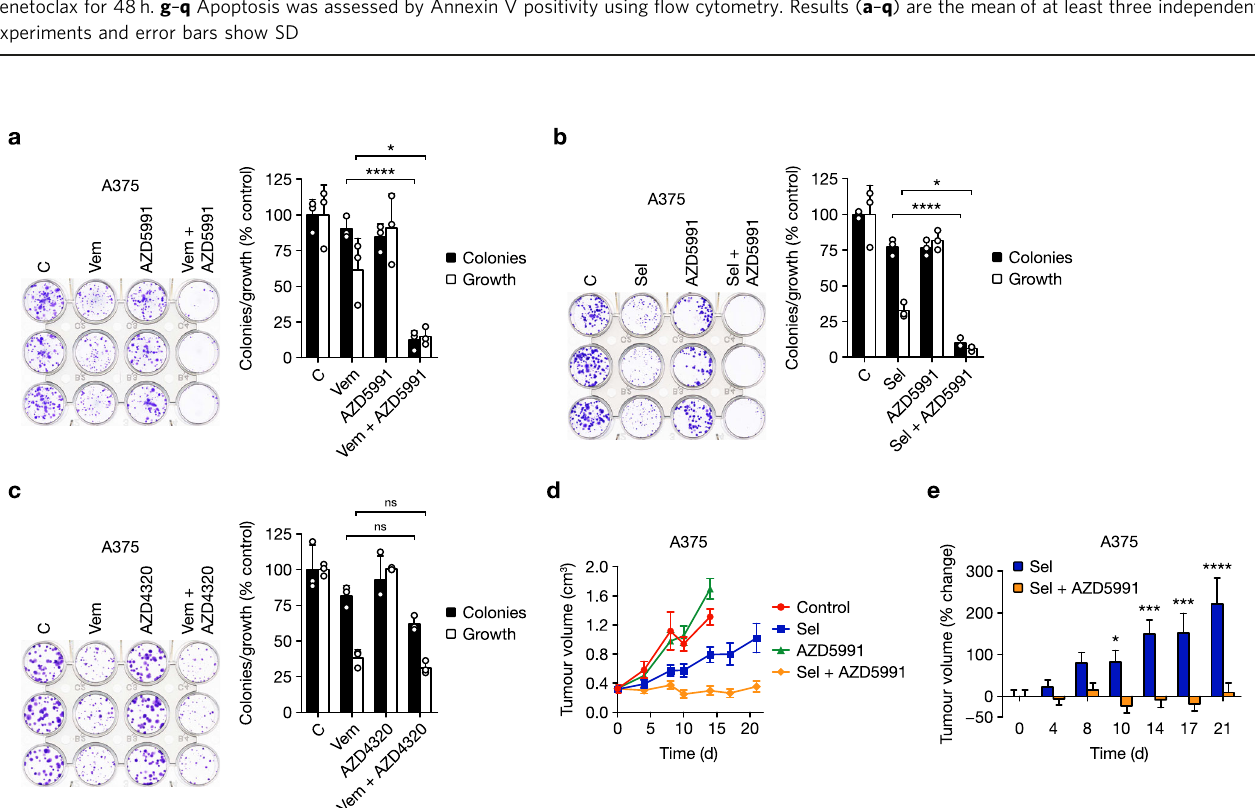
Fig. 2 ERK1/2 pathway inhibitors combine with the MCL1 inhibitor AZD5991 to kill melanoma cells. a – c A375 ( a ), SK-MEL-28 ( b ) and WM266-4 ( c ) cells were treated with the indicated concentrations of trametinib or vemurafenib in combination with AZD5991 for 5 days. The number of viable cells was determined at the point of treatment (day 0) and at the end of the experiment using Sytox Green. One-hundred percent represents the number of viable cells in the control wells at day 5, 0% is equivalent to the number of viable cells on day 0 and − 100% indicates that no viable cells remained on day 5. d , e Twelve melanoma and 12 colorectal cancer (CRC) cell lines were treated with trametinib (Tra) or selumetinib (Sel) and AZD5991 or AZD4320 in an 8 × 8 concentration matrix for 5 days. Viable cell number (determined as above) was used to calculate Loewe synergy scores using the Loewe additivity model. P ≤ 0.01 (**), P ≤ 0.05 (*), ns (not signi fi cant) as determined by unpaired or paired two-tailed t -test. f A375 cells were treated with increasing concentrations of vemurafenib (Vem) with or without 1 μ M AZD5991 for 48 h. Cell cycle pro fi le was determined by propidium iodide staining and fl ow cytometry. g , h A375 cells were treated with increasing concentrations of vemurafenib (Vem) ( g ) or selumetinib (Sel) ( h ) with or without 1 μ M AZD5991 for 48 h. i The indicated tumour cell lines were treated with DMSO control (C), 1 μ M vemurafenib (Vem), 1 μ M selumetinib (Sel) and 0.3 μ M SCH772984